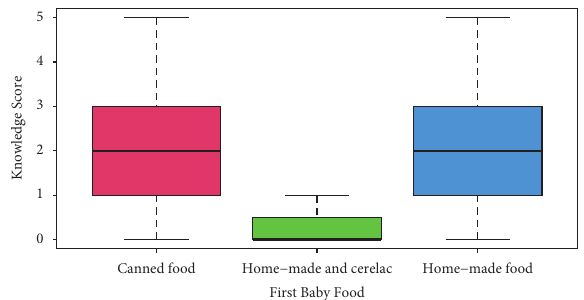
Figure 2: Compared to canned food (the red box-and-whiskers plot; n � 151, 39.2%, μ � 2.2 points), mothers who used home-made food and cerelac preparation scored the least knowledge score (the blue box-and-whiskers plot; n � 4, 1%, μ � 0.3 points, p � 0 . 0013), whereas women who used home-made food only (the green box- and-whiskers plot) were majority ( n � 230, 59.7%, μ � 1.9 points, p � 0 . 0211).